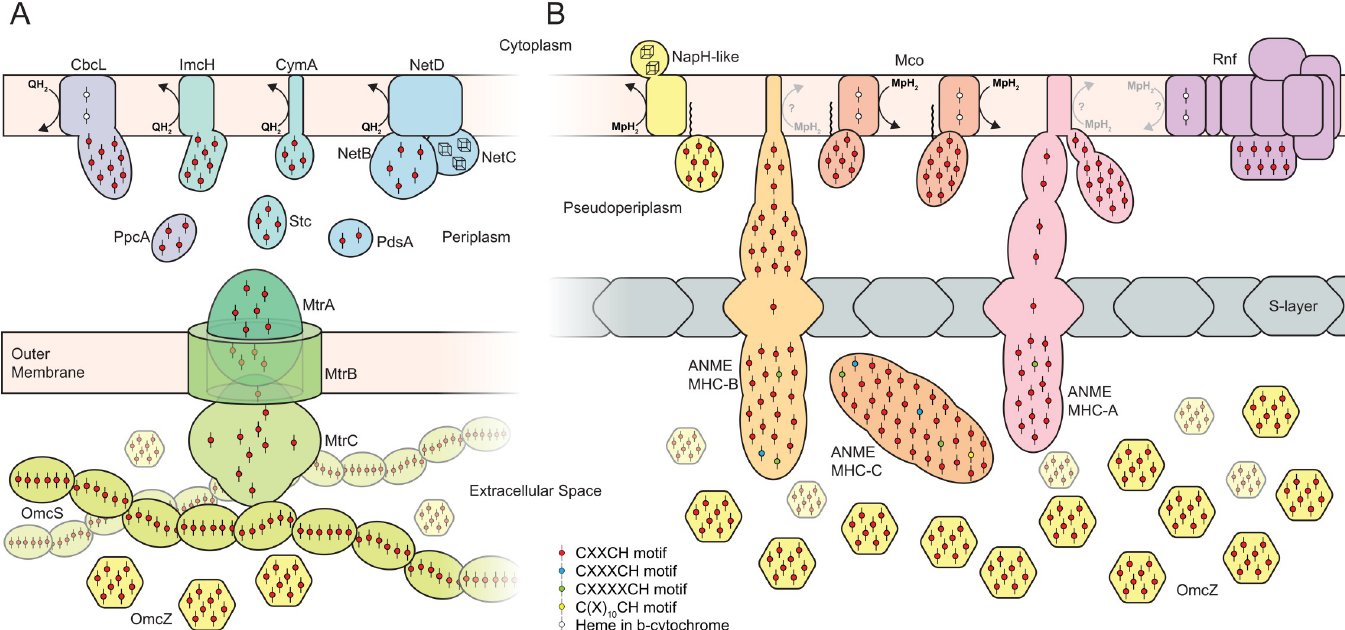
Fig 9. Overview of proposed EET pathways. Comparison between EET systems known from gram-negative bacteria and proposed analogous systems in ANME archaea. ( A ) EET systems in gram-negative bacteria involve membrane-bound quinol:cytochrome c oxidoreductases (CbcL, ImcH, CymA, NetD), small soluble cytochromes apparently involved in electron transport through the periplasmic space (PpcA, Stc, PdsA), and a beta-barrel/decaheme cytochrome c protein complex (MtrCAB) that acts as an electron conduit by which electrons can transit through the outer membrane to the extracellular space filled with additional cytochrome c such as OmcZ and filaments of OmcS. ( B ) Analogous protein complexes found in ANME genomes that appear optimized for the challenges associated with EET in the archaeal cell architecture. MpH 2 :cytochrome c oxidoreductases are likely present in the form of gene clusters containing VhtC cytochrome b subunits together with large 7 or 11 heme- binding MHC proteins (Mco). Other potential options for this step could include the NapH homologs sporadically distributed through ANME genomes or through the action of the unique cytochrome b gene found in ANME Rnf clusters. Electron transfer through the outer proteinaceous S-layer requires a different mechanism than the beta-barrel/decaheme cytochrome strategy evolved in the EET-capable bacteria containing an outer membrane. This step is expected to be overcome by the giant ANME- specific MHC proteins containing S-layer domains allowing them to integrate into the S-layer structure. Very close homologs of OmcZ are found in ANME (see Fig 10 ). For details of S-layer MHC fusions, see Fig 11 . ANME, anaerobic methanotrophic; EET, extracellular electron transfer; Mco, methanophenazine-cytochrome c oxidoreductase; MHC, multiheme c -type cytochrome; Rnf, Rhodobacter nitrogen fixation.